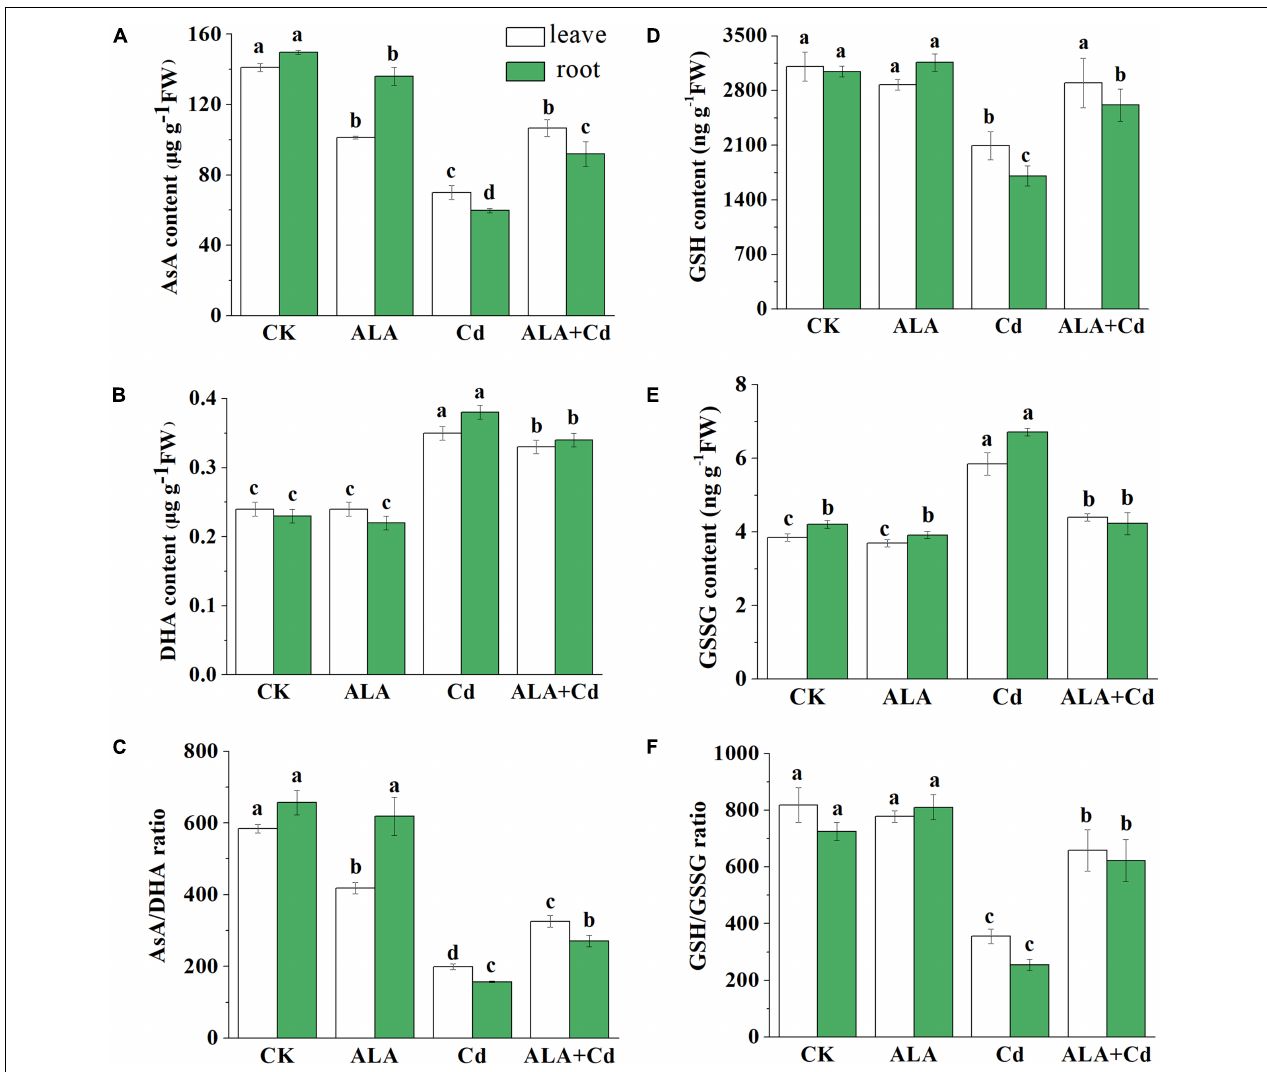
FIGURE 7 | Effects of ALA under cadmium stress on contents of AsA, DHA, GSH, and GSSG in cabbage. (A) AsA; (B) DHA; (C) AsA/DHA; (D) GSH; (E) GSSG; (F) GSH/GSSG. The seedlings were treated as in Figure 1 . The mean ± SE are shown ( n ≥ 3). Different letters indicate significant difference among the treatments ( P <